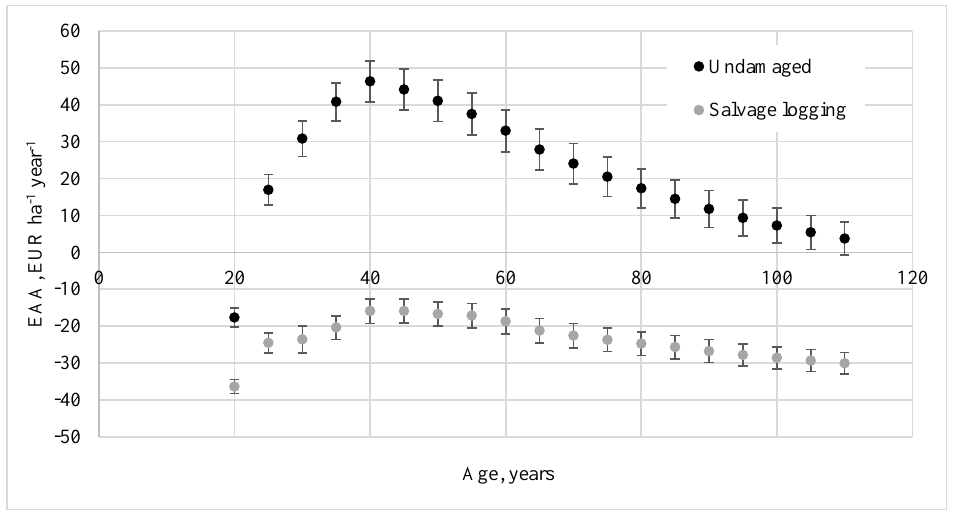
Figure 1. The average equivalent annual annuity (EAA) of planted Scots pine stands on fertile soils (SI 32 and SI 36) at different ages, applying a 3%–5% interest rate for undamaged and salvage-logged sites. Whiskers denote the 95% confidence intervals of the EAA.